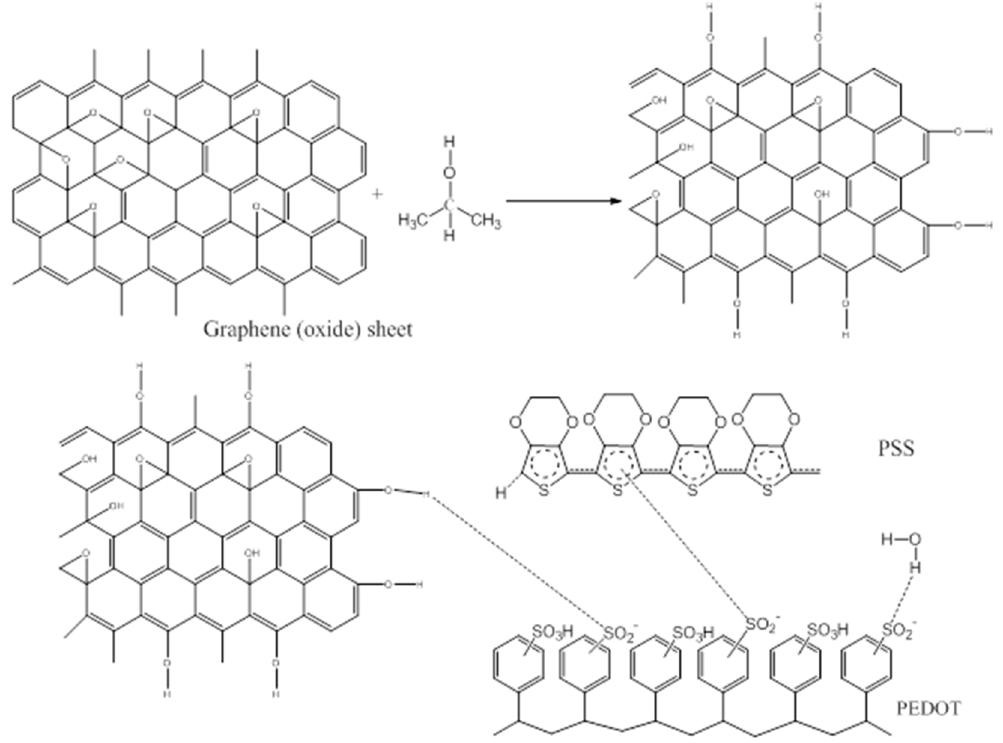
Figure 5. Proposed synthesis route and chemical interactions between graphene and PEDOT:PSS in IPA and water.